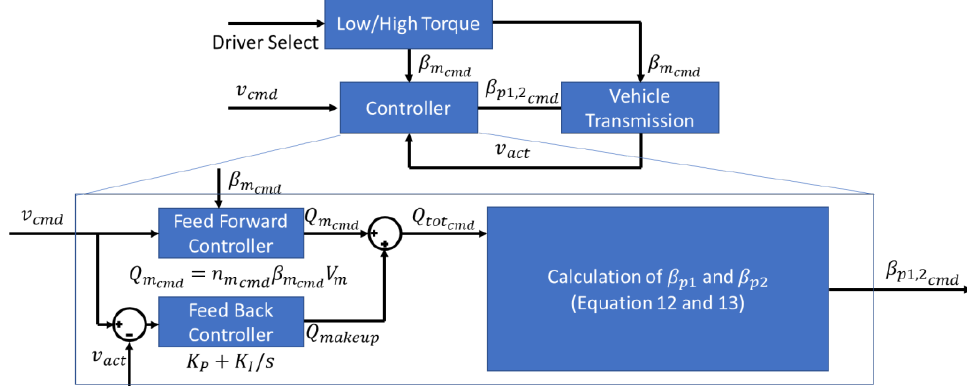
Figure 8. Control Block Diagram for the HT Solution A and B.